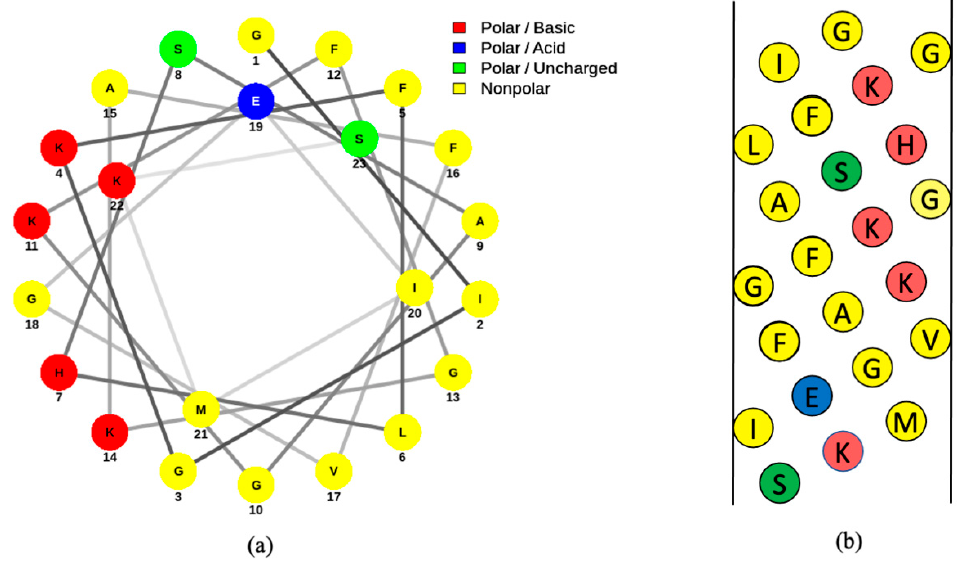
Figure 3. Amino acid sequence of magainin I and magainin II [36]. Two locations of mismatched amino acids on the peptide sequence are highlighted in yellow.